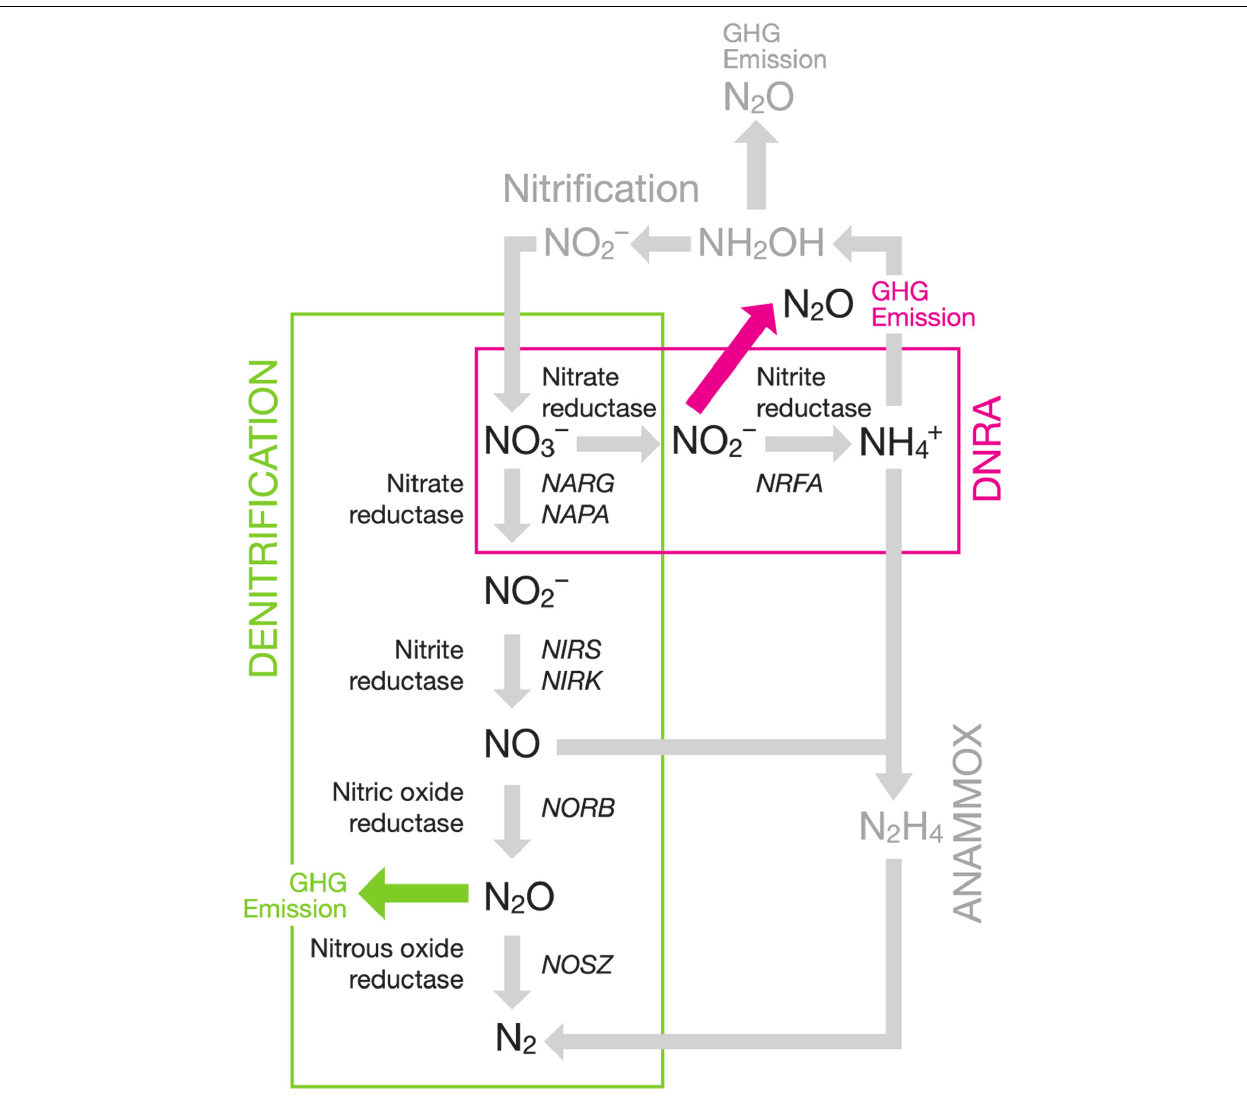
FIGURE 1 | Partial soil nitrogen cycling pathways with an emphasis on denitrification and DNRA showing the enzymes involved and genes commonly used as